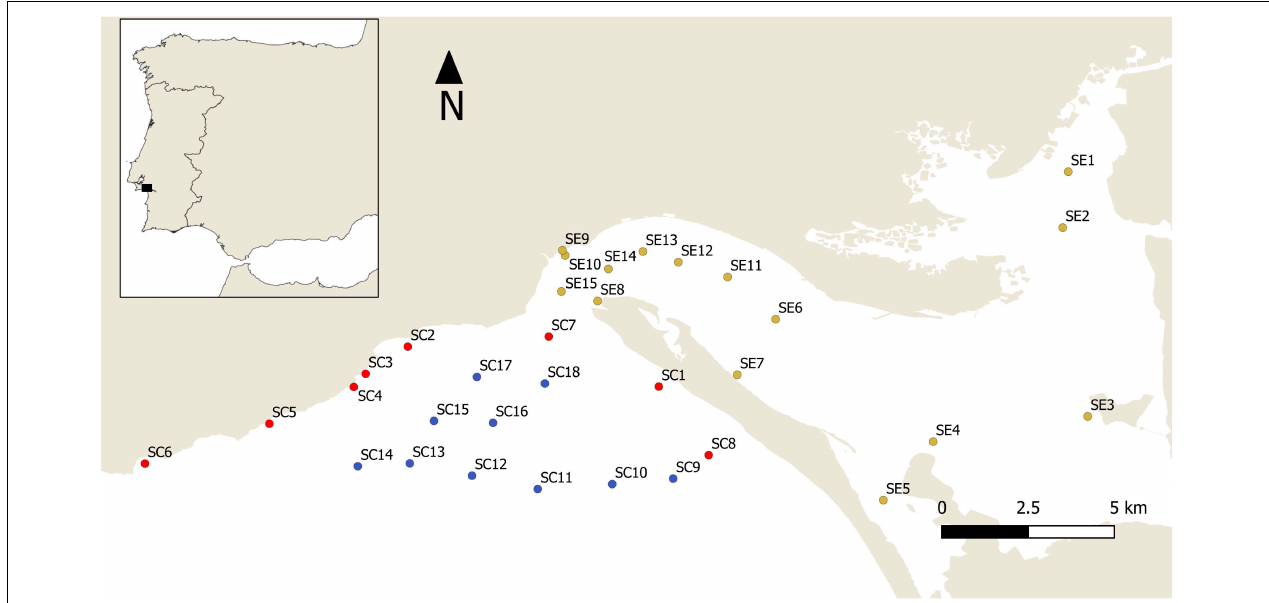
FIGURE 1 | Map of the study area, with sampling sites, grouped according to habitat type, classified as; estuary (yellow); coastal (red); and offshore